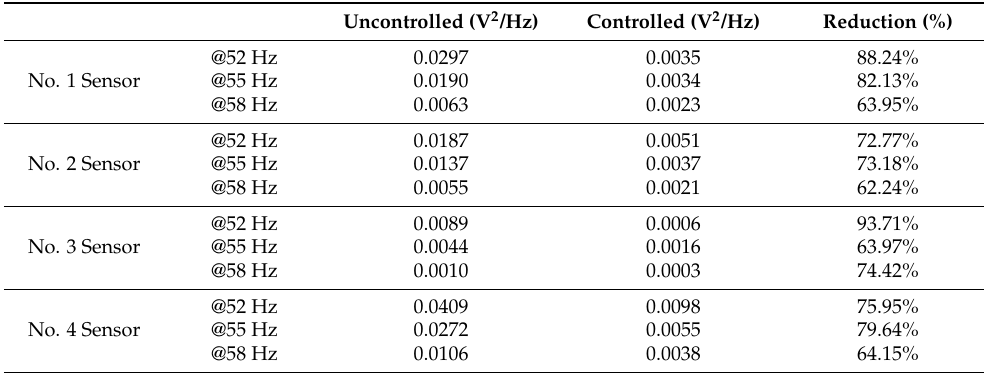
Figure 10. PSDs of sensor signals obtained by simulations. Table 1. RMS values of sensor signals: Simulation #1.